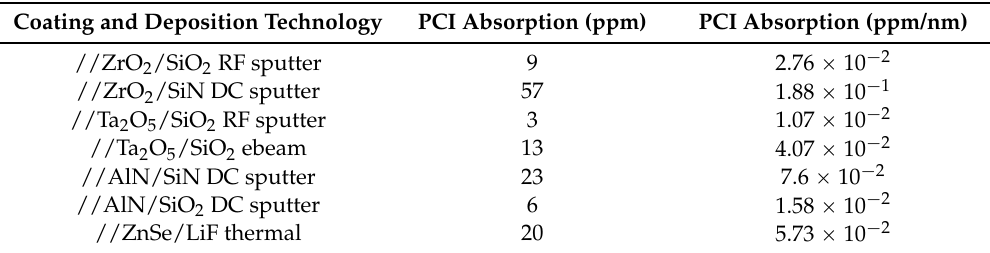
Table 4. PCI baseline absorption values for the AR coatings.